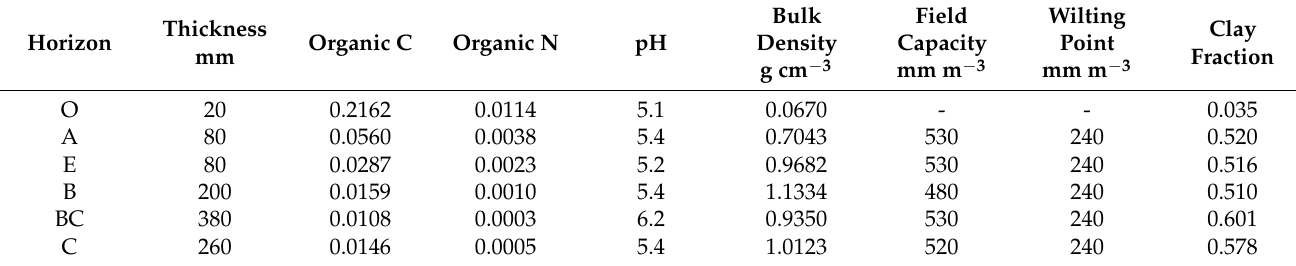
Table 2. Soil property initialisation for the Straits Inclosure for use with the LandscapeDNDC model. Soil texture: silty clay; Humus type: mull; Hydraulic conductivity (in horizons A–C): 0.00006 cm min − 1 . Water table: 1.1 m; no stones.